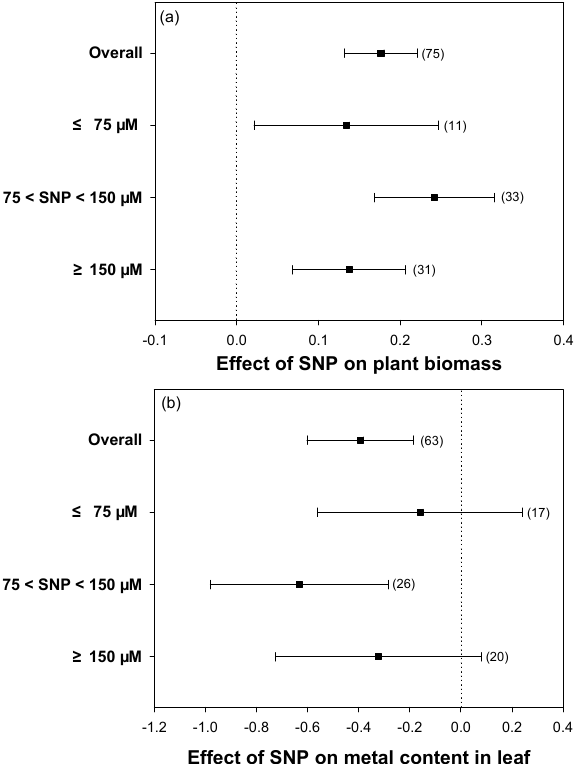
Figure 7. Plots of effect sizes for the effect of different SNP concentrations on ( a ) plant biomass and ( b ) metal content in leaves. The numbers in brackets specify the number of data points. The black square block with the error bar indicates the mean response size with a 95% confidence interval, and the dashed vertical line shows zero